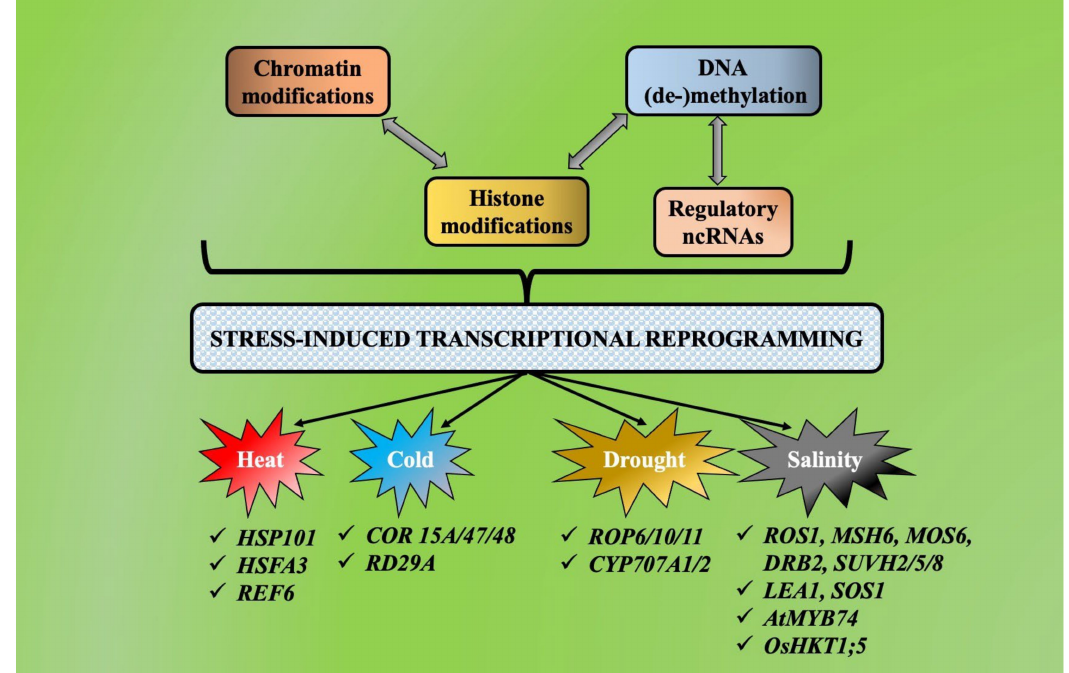
Figure 3. Crosstalk between chromatin modification, histone modification, DNA(de-)methylation and non-coding RNAs during abiotic stress-induced transcriptional reprogramming. Major epigenetic regulators such as chromatin remodelers, histone variants, DNA modifiers and ncRNAs interact with each other in a cooperative manner under abiotic stresses (heat, cold, drought, salinity) to portray a multilayered stress-induced epigenetic regulations in